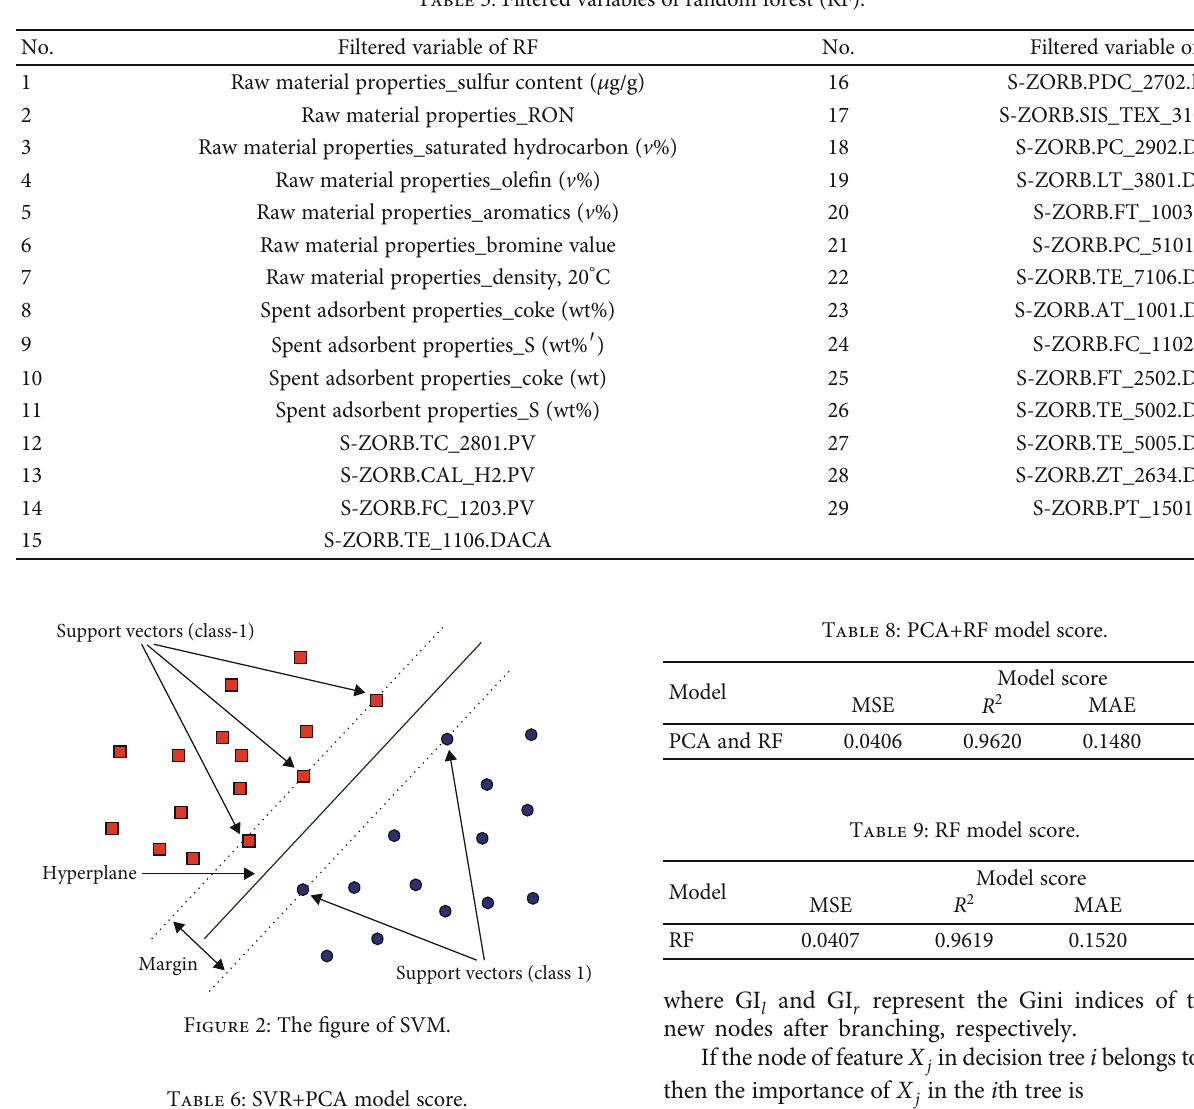
Table 5: Filtered variables of random forest (RF).